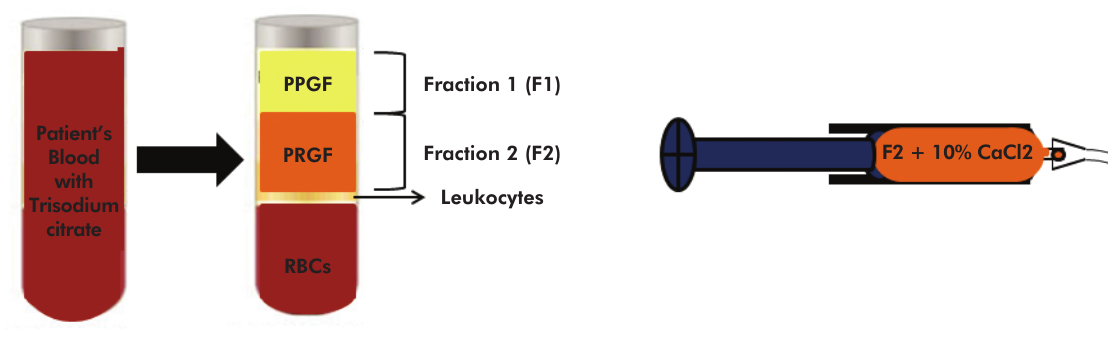
Figure 1. Schematic representation of PRGF F2 Gel used for intra-pocket